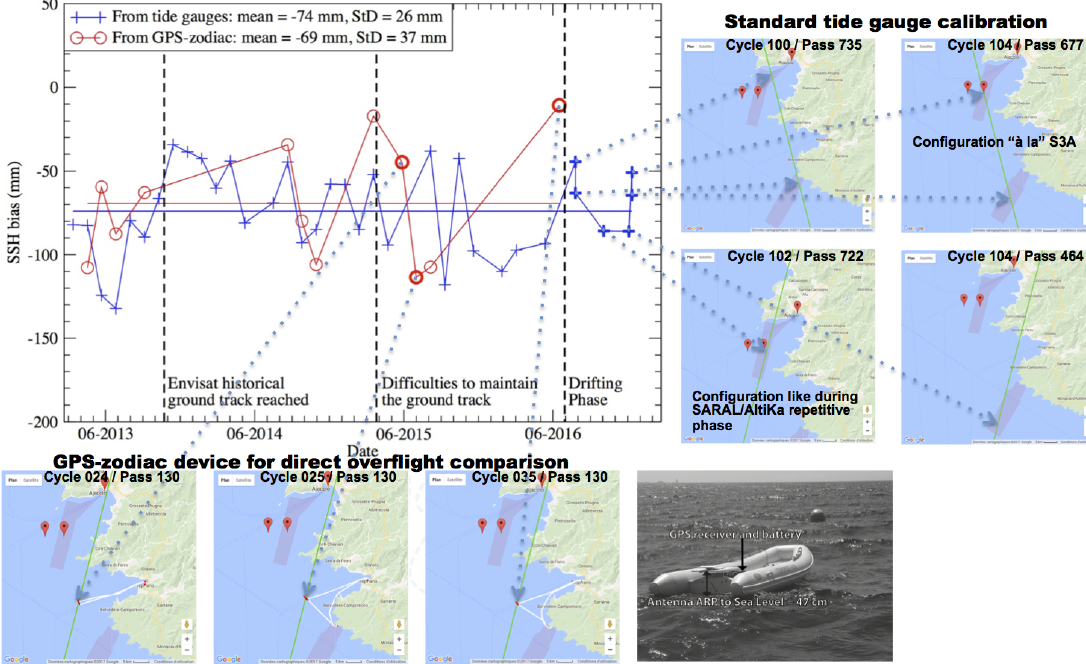
Figure 5. Sea Surface Height (SSH) bias time series for SARAL/AltiKa over Corsica for both direct (GPS-zodiac, red circles) and indirect (tide gauges, blue crosses) approaches. The bold symbols correspond to situations where the satellite was not overflying the calibration sites in a nominal